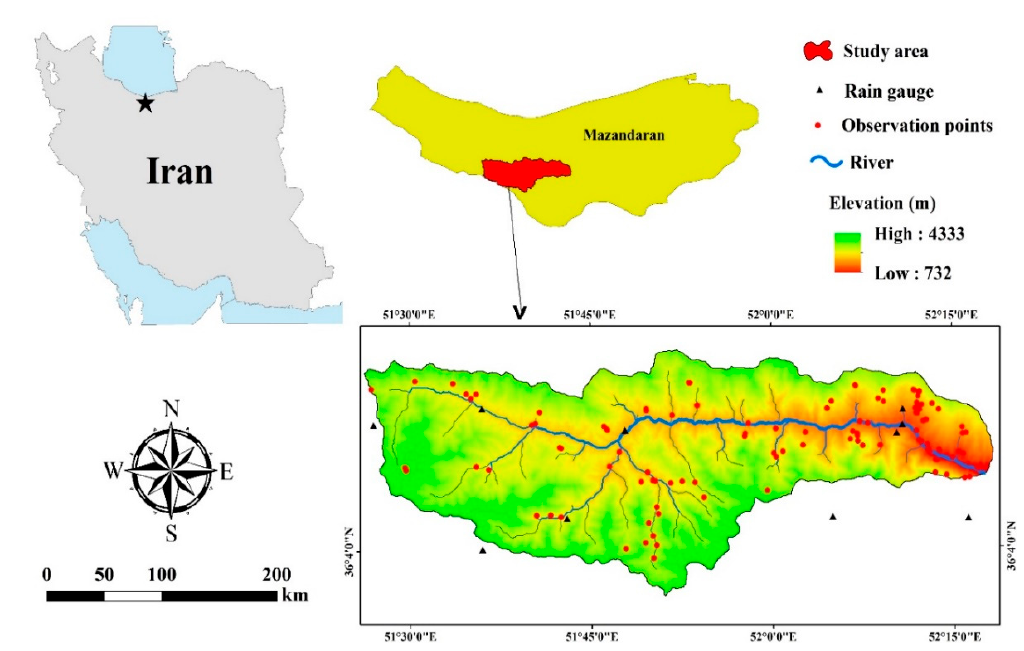
Figure 1. Location of the Nur-Rood watershed, Mazandaran province, Iran.